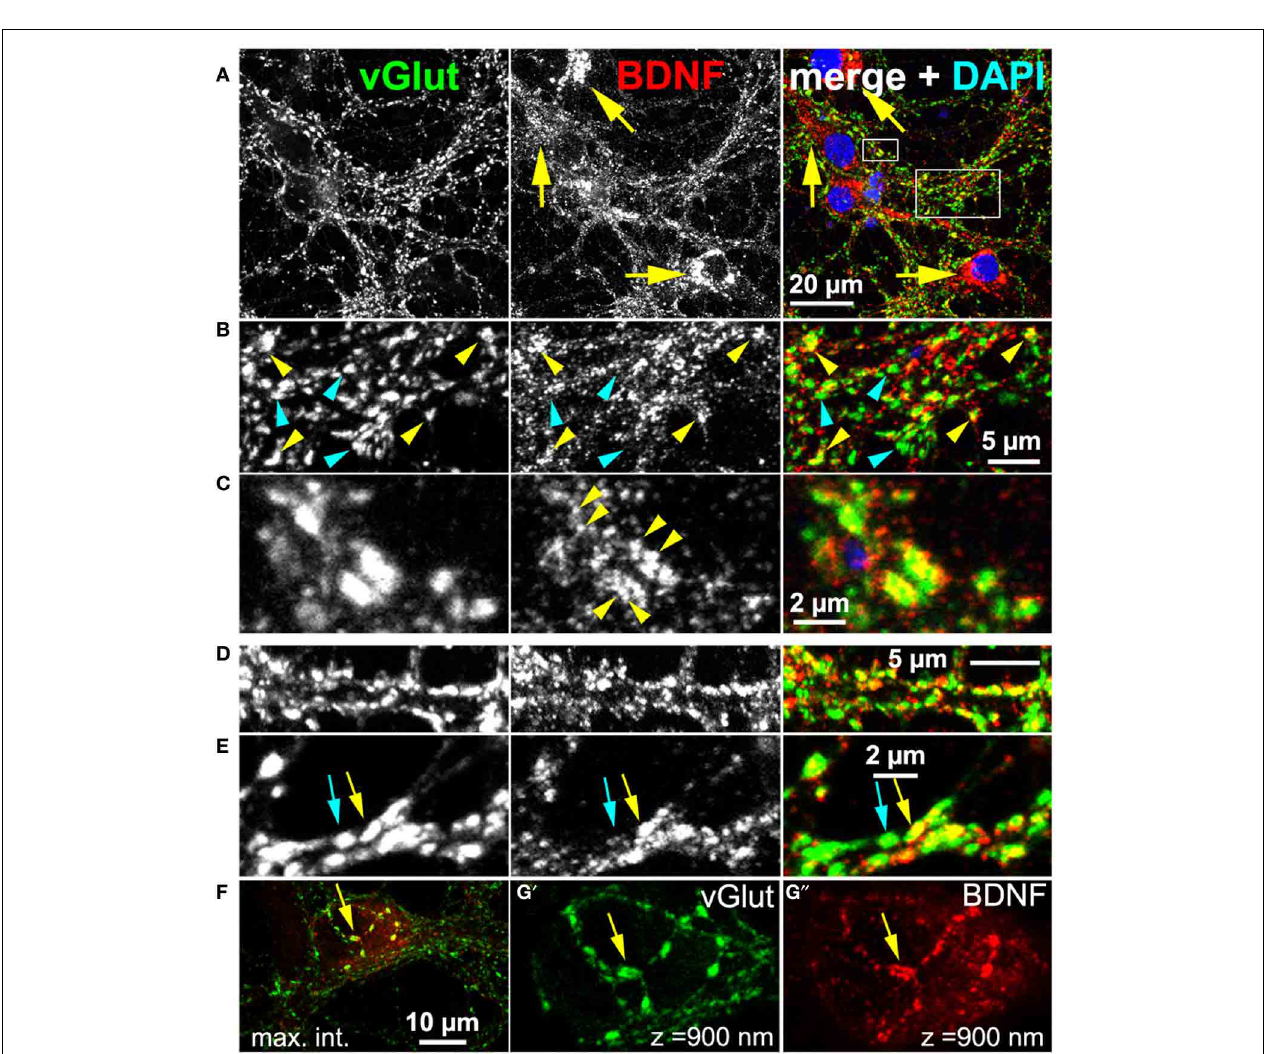
FIGURE 2 | Endogenous BDNF at glutamatergic synapses (DIV 38). (A–C) Hippocampal neurons with high amounts of BDNF in somatic regions (yellow arrows). (B) ( detail of A) , BDNF IR was found in close proximity to some (yellow arrowheads), but not all vGlut + synapses (cyan arrowheads). (C) ( detail of A) , Single vGlut + structures exhibited a dense, polymorphic, vesicle-like BDNF signal (yellow arrowheads in middle panel). (D,E) vGlut + /BDNF-rich (yellow arrow) and